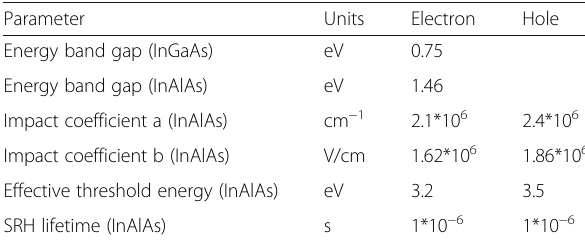
Table 1 Material parameters used in the simulation of InGaAs/